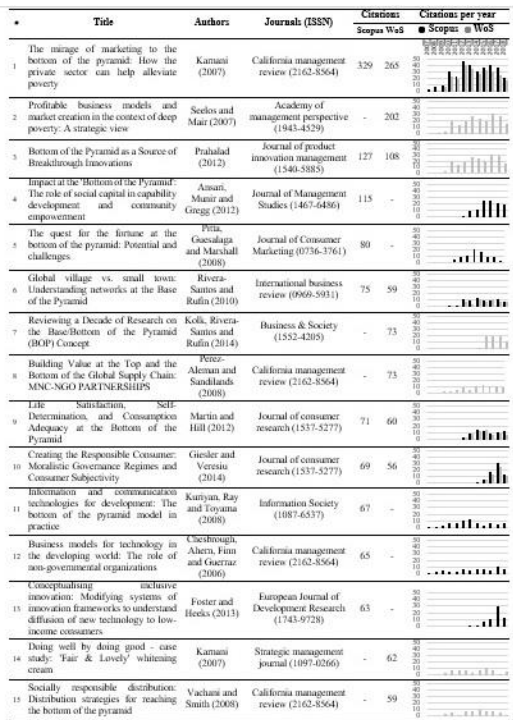
Table 1: Most Frequently Cited Articles in the Literature on BoP in Scopus and Web of